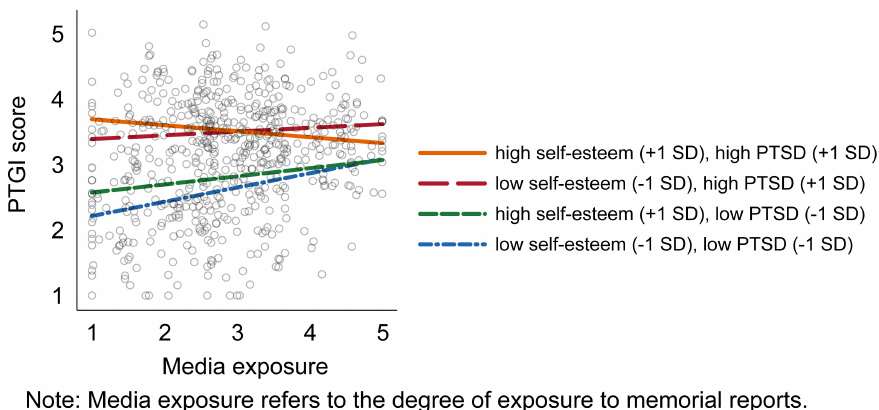
Figure 1. PTG as a function of self-esteem and PTSD symptoms across di ff erent degrees of exposure to memorial reports. Table 3. Slope di ff erence test of three-way